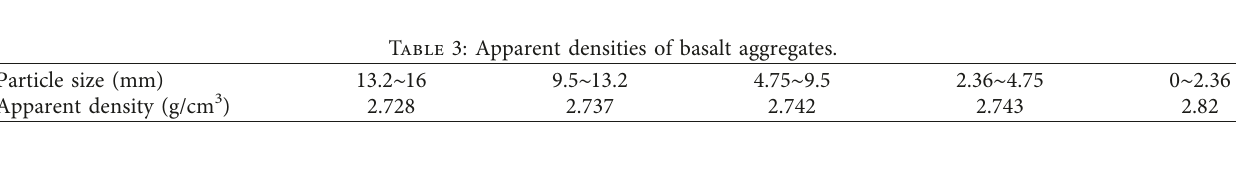
Table 4: Mineral gradations of AC-13 and PA-13 mixtures.